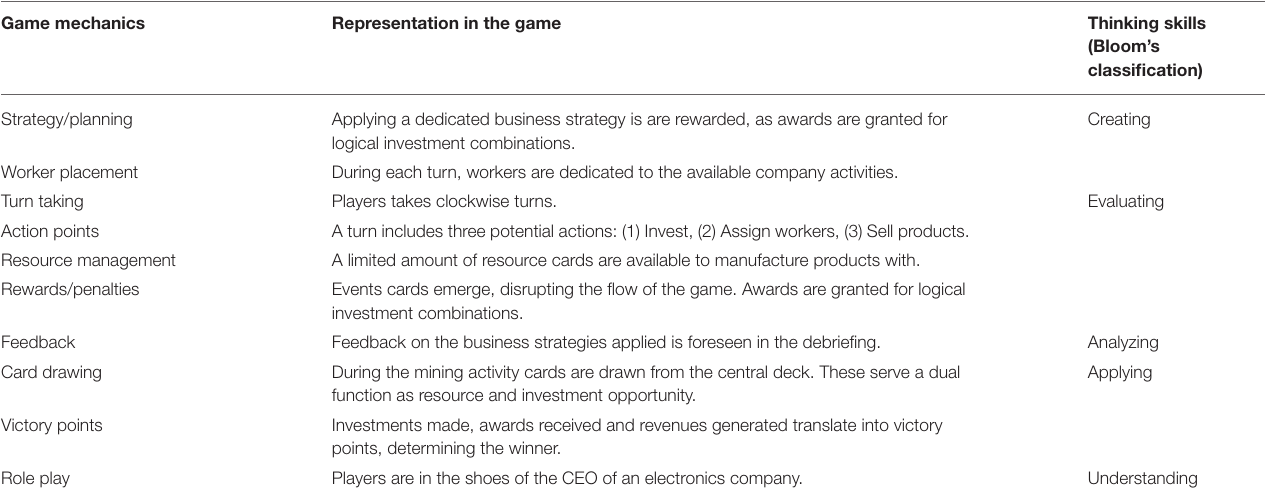
TABLE 1 | Game mechanics and related thinking skills in the ecoCEO game. Game